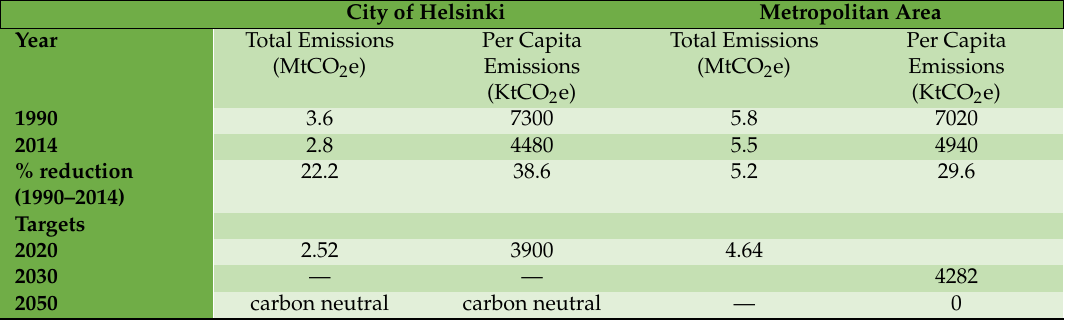
Figure 2. Carbon reduction projection for the Helsinki metropolitan area. Note: Figure 2 was created using data accessed from Helsinki Environmental Statistics 2015, Helsinki Region Environmental Services Authority (HSY) and the City of Helsinki Environmental Report from 2014. Table 3. Carbon emissions reduction objectives for the city of Helsinki and the metropolitan area. City of Helsinki Metropolitan